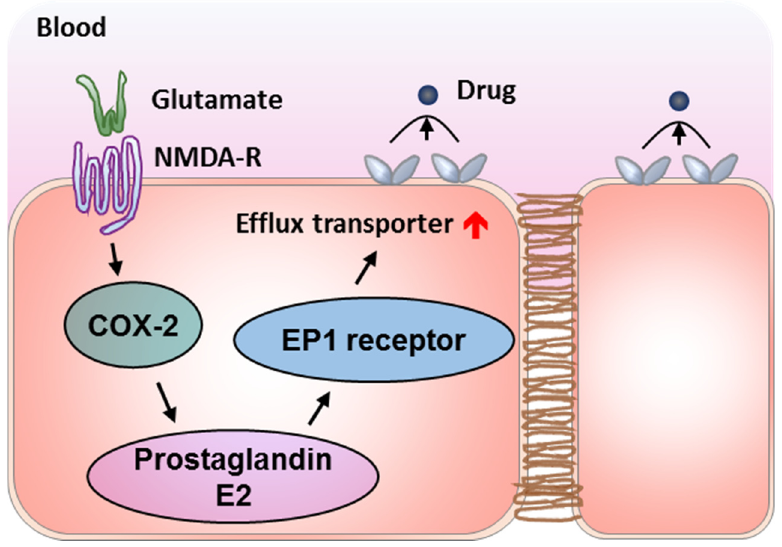
Figure 4. The signaling pathway of glutamate/NMDA-R/COX-2/prostaglandin E2 EP1 receptor induces the upregulation of efflux transports in epilepsy.